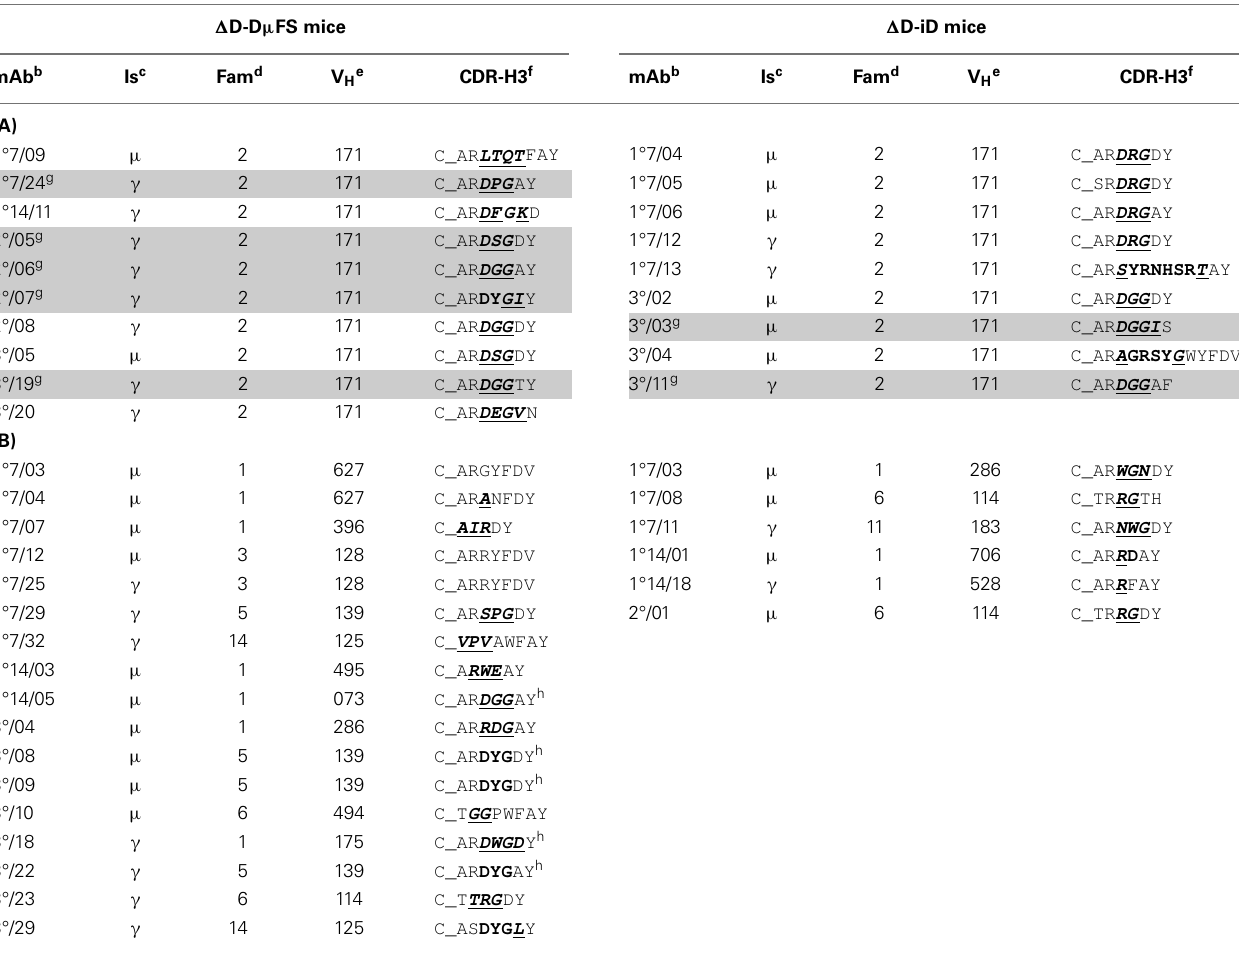
Table 2 | CDR-H3 amino acid sequences of (A)V H 171- and (B) non-V H 171-encoded monoclonal anti-phOx antibodies from D-altered ∆ D-D µ FS and ∆ D-iD mutant mice a